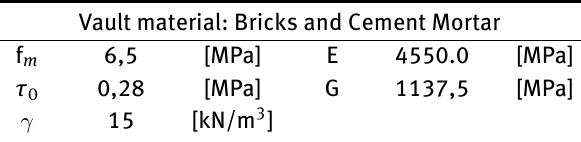
Table 1: Mechanical characteristics of the selected masonry Vault material: Bricks and Cement